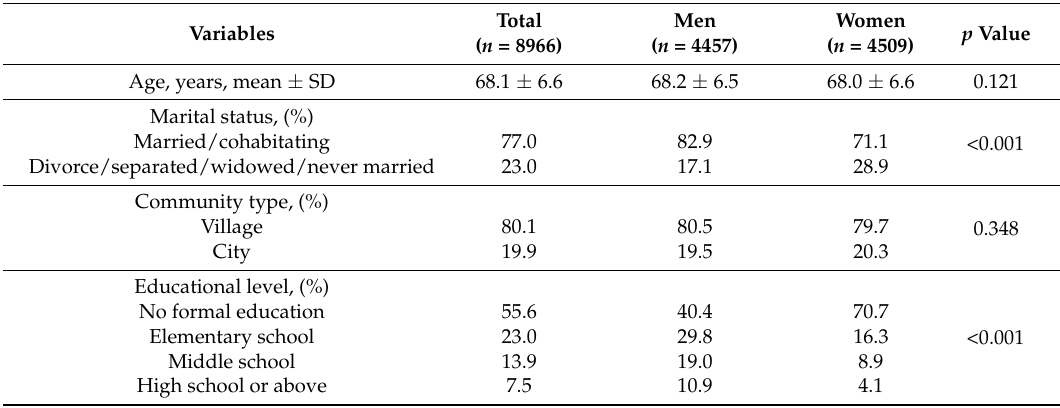
Table 1. Characteristics of the study